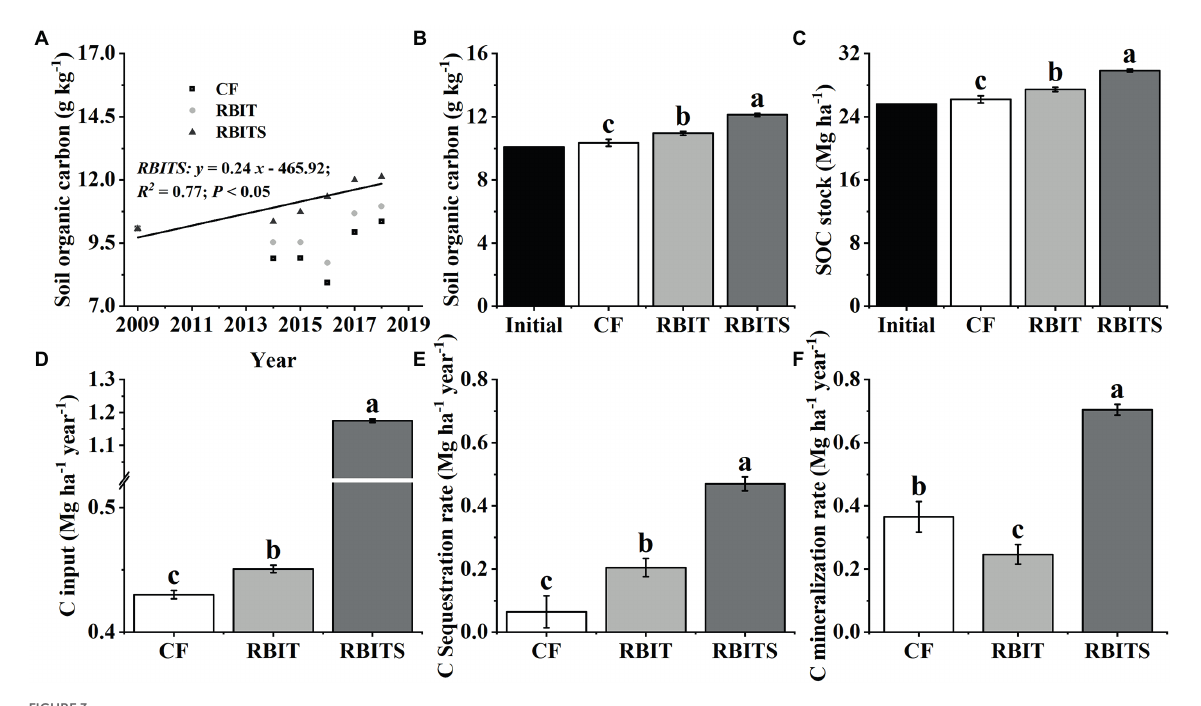
FIGURE 3 Effect of fertilization management on SOC dynamics (A) , SOC in 2018 (B) , SOC stock (C) , C input (D) , C sequestration rate (E) , and C mineralization rate (F) in the bulk soil (0–20 cm). CF : conventional fertilization; RBIT: reduced basal and increased topdressing fertilizer rate; RBITS: RBIT combined with straw incorporation. Different lowercase letters represent significant differences ( p ≤ 0.05) among treatments for the same crop type. Error bars are standard error (SE) of the